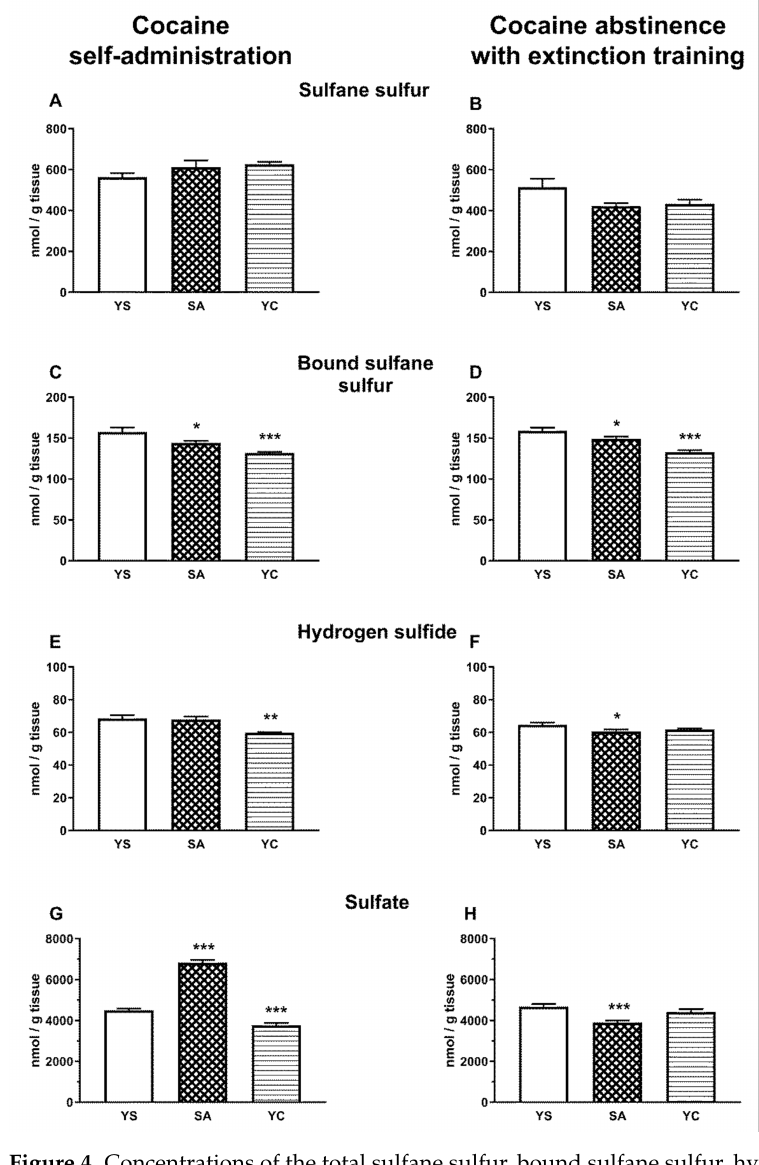
Figure 4. Concentrations of the total sulfane sulfur, bound sulfane sulfur, hydrogen sulfide, and sul- fate in the presence of cocaine ( A , C , E , G ) and after 10 days of drug abstinence with extinction training ( B , D , F , H ) in the livers of rats self-administering cocaine (SA), receiving passive cocaine infusions (YC), or receiving saline infusions (YS): data are presented as the mean ± SEM, n = 8–10 per group. * p < 0.05, ** p < 0.01, *** p < 0.001 vs. YS